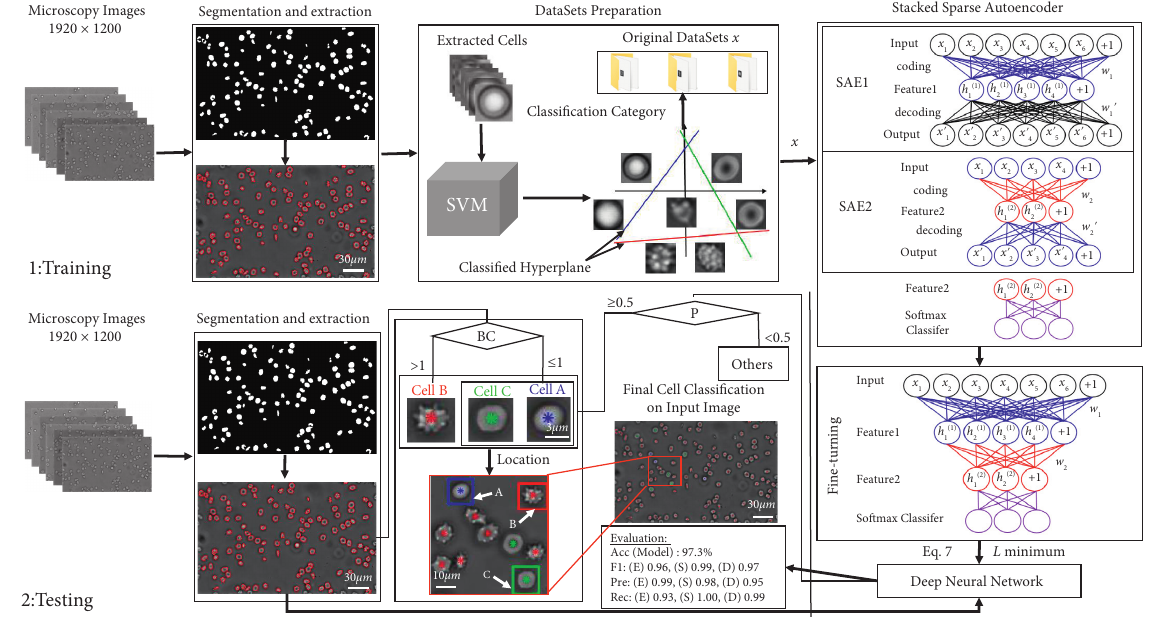
Figure 1: Schematic illustration of the RBC classification process. The process is divided into two stages: training and testing. In the training phase, the model of SSAE trained by the original image block is fine tuned to obtain the DNN. In the testing phase, the BC, DNN, and Softmax classifier are used to classify the cells in the unknown images, where cells A, B, and C are the spherocyte, echinocyte, and discocyte in the prediction results,